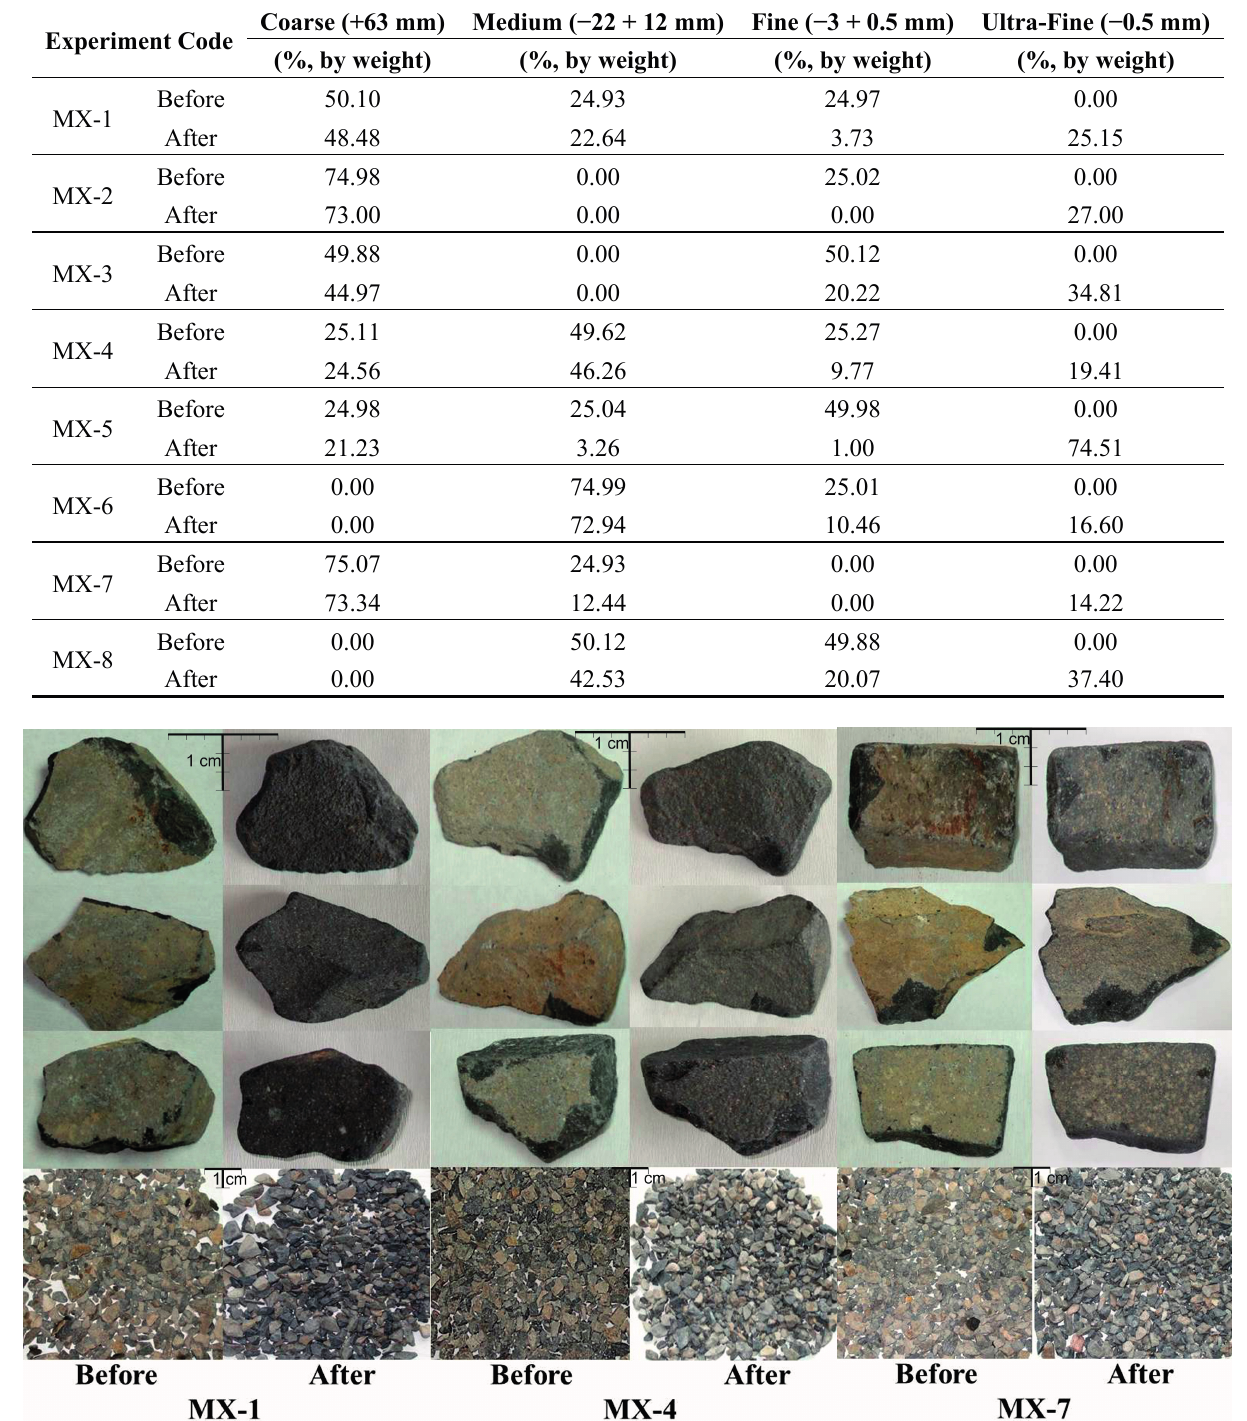
Figure 4. Particles of basaltic waste-rock before and after tumbling for MX-1, MX-4 and MX-7 mixtures (particles of +63 mm coarse and − 22 +12 mm medium size